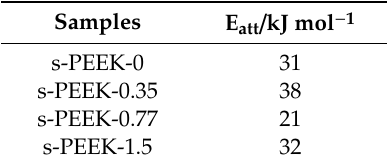
Table 3. Activation energy for the developed